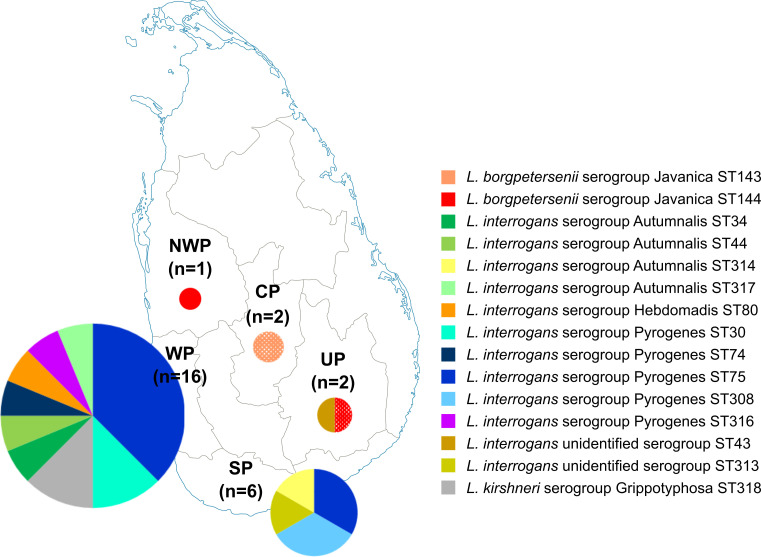
Distribution of 27 Leptospira strains isolated in Sri Lanka.One isolate of ST144 in UP and two isolates of ST143 in CP were isolated from rats (indicated by dots in the pie charts), and others were isolated from human patients. CP, Central Province; NWP, North-Western Province; SP, Southern Province; UP, Uva Province; WP, Western Province.